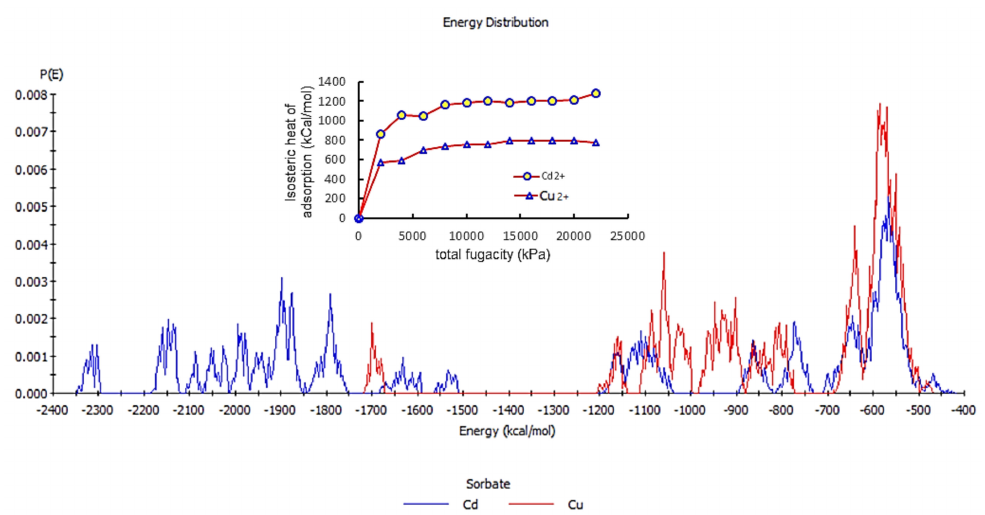
Figure 12. Energy distribution and isosteric heat of adsorption for Cd 2+ and Cu 2+ by the nanosilica